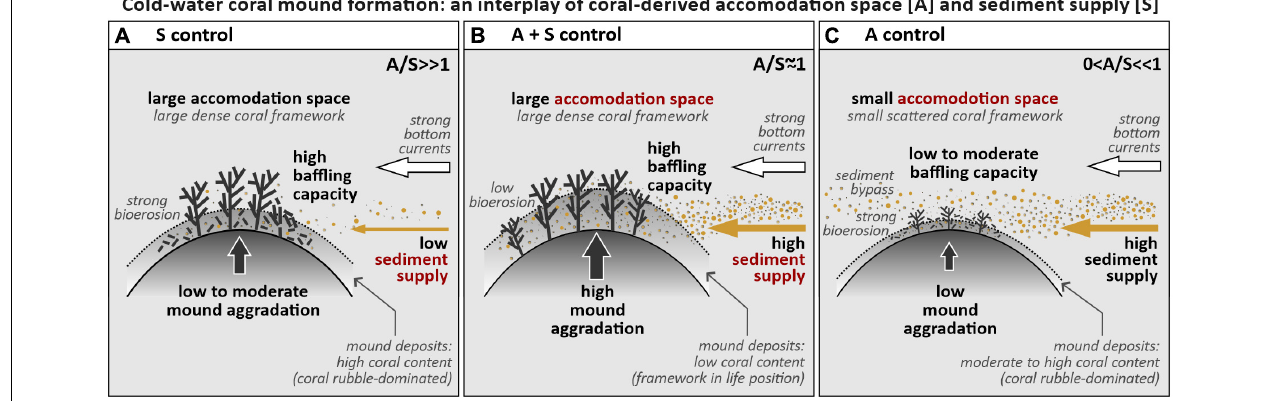
FIGURE 4 | Scheme showing three different scenarios of cold-water coral mound formation and associated mound aggradation rates (ARs) resulting from the interplay between sediment supply (S) and the growth of framework-forming corals providing ecological accommodation space (A). (A) The coral-derived A exceeds S (A/S > > 1). Large and densely distributed coral frameworks result in a high baffling capacity and provide large A. As S is too low to completely fill the coral-derived A, the coral frameworks become exposed to bioerosion and fragmentation, which causes their collapse and the deposition of coral rubble (high coral content in mound deposits). The associated AR is low to moderate and mainly controlled by S. (B) The coral-derived A is equal to S (A/S ∼ 1). Large and densely distributed coral frameworks result in a high baffling capacity. Due to a high S, the large A provided by the coral frameworks becomes rapidly filled preventing bioerosion and preserving the coral frameworks in life position (low coral content in mound deposits). The associated AR is high and controlled by A and S. (C) The coral-derived A is outpaced by S (0 < A/S < < 1). Due to less optimal environmental conditions, only small coral frameworks are present on the mound, which are distributed in a scattered manner and provide only small A. The low to moderate baffling capacity limits the on-mound deposition of current-transported sediments. Consequently, the coral frameworks are largely exposed to bioerosion and fragmentation, which causes their collapse and the deposition of coral rubble (moderate to high coral content in mound deposits). Despite the high S, the associated mound AR is very low as it is mainly controlled by